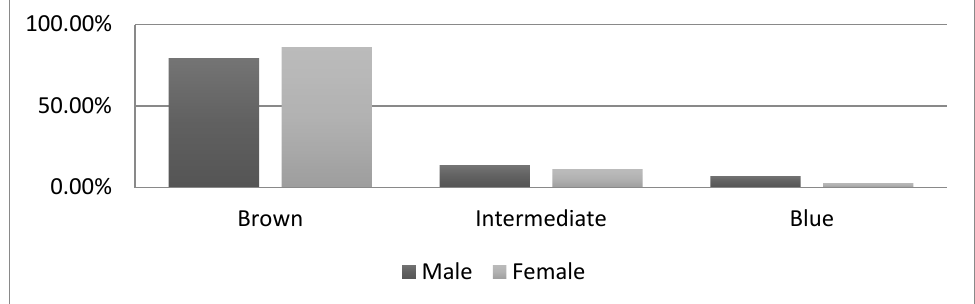
Figure 2. Percentage of eye colour based on gender . Table 1. Multinomial logistic regression analysis between gender and eye colour. The bold value indicated the signi fi cance with eye colour.